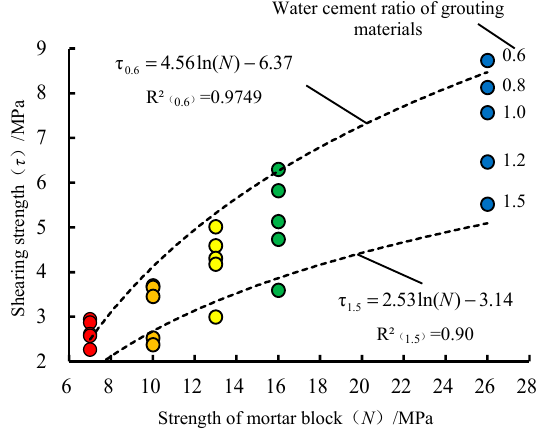
Figure 8. Characteristics between water-cement ratio( W / C ) and ττ .